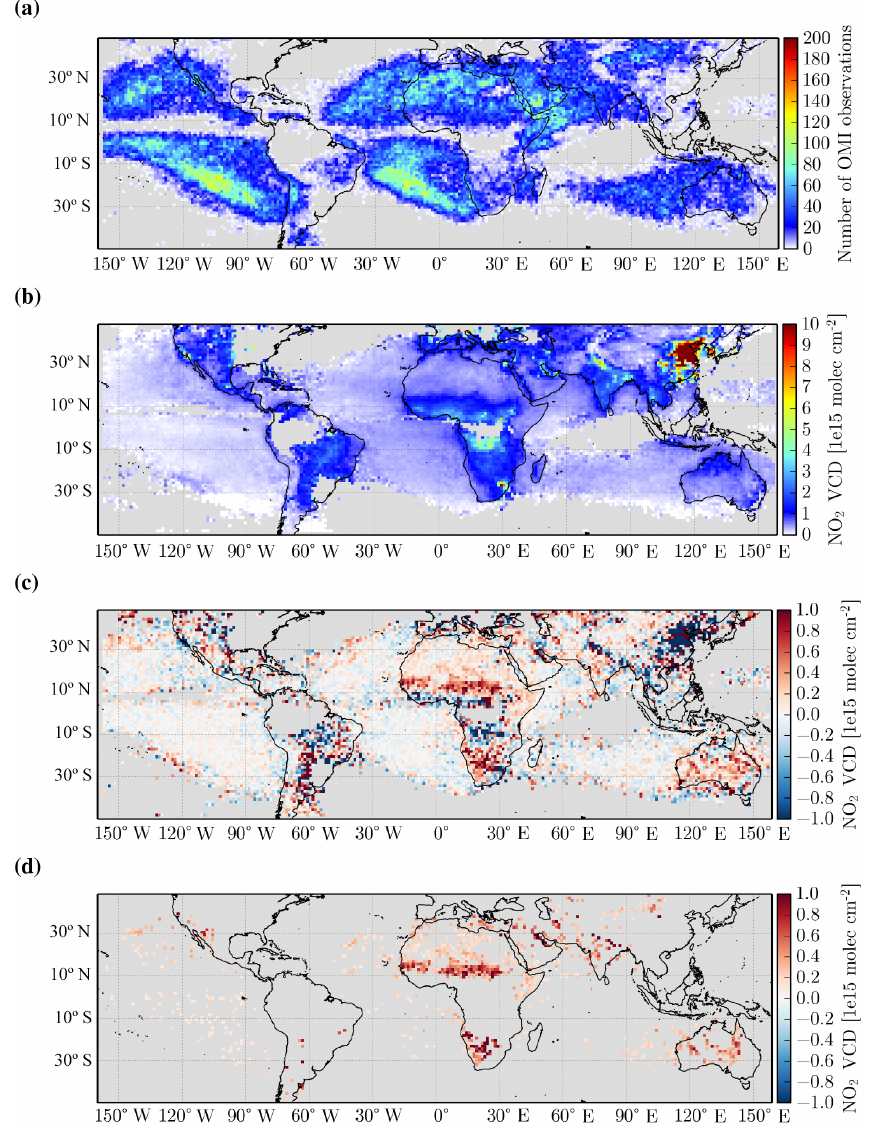
Figure 3. (a) Number of valid measurements per grid pixel on Day0. (b) OMI NO 2 background levels averaged for days − 10 to − 2 before the first rain event after 60 days of drought for each pixel (0.25 ◦ lat/long) and then averaged for boxes of 1.25 ◦ lat/long. (c) OMI NO 2 VCD absolute differences on Day0 (first day of rainfall) compared to Days − 10 to − 2. Reductions in NO 2 VCDs on Day0 depicted in blue colours, enhancements in red. (d) as (c) but screened for significant changes (see text). Extensive enhancements over the Sahel and South Africa are evident. Pixels containing less than 20 measurements on Day0 (or less than 50 measurements from Day − 10 to Day − 2) are screened